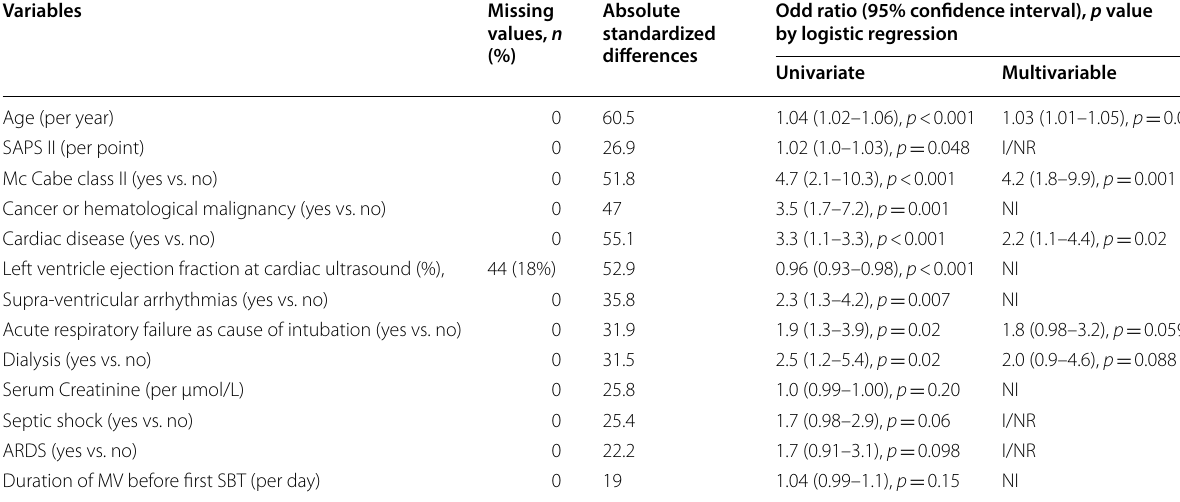
Table 1 Univariate and multivariable analysis of factors associated with moderate-to-large pleural